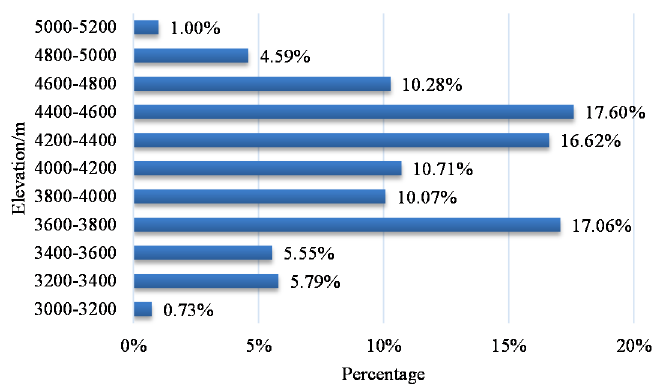
Figure 4. The elevation distributions of rockfall source areas in the study area.